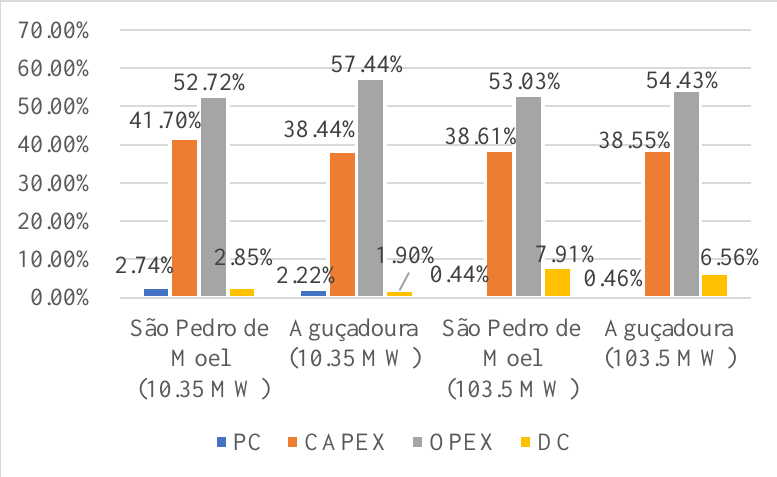
Figure 6. Percentage of the cost center towards total cost of W2Pow technology.